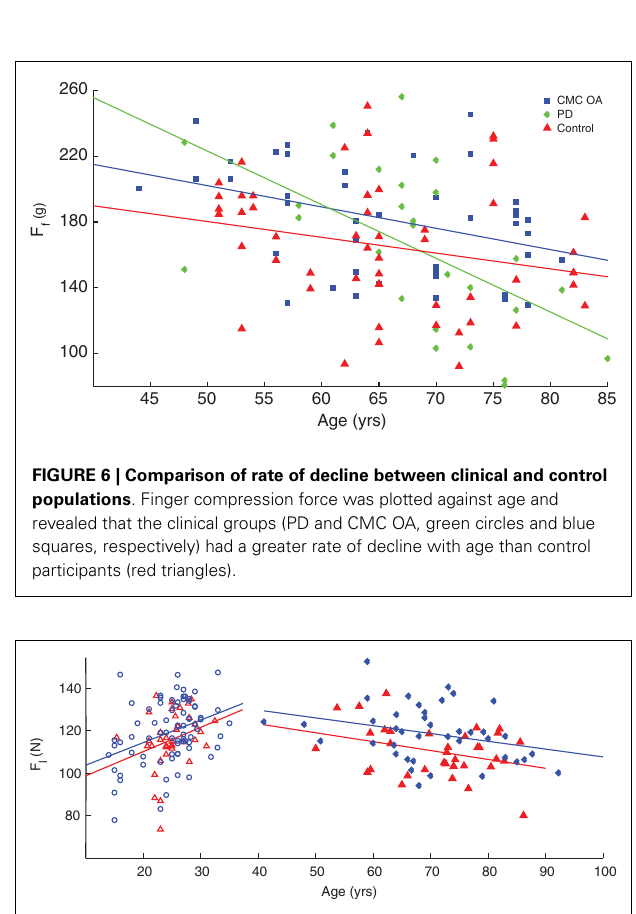
FIGURE 7 |Age- and gender-related changes in leg compression force . Regressions against age indicated an increase in younger adults (empty symbols) and a decrease in older adults (filled symbols). Male participants (blue circles) tended to have greater values than females (red triangles) as indicated by the position of the fit lines.